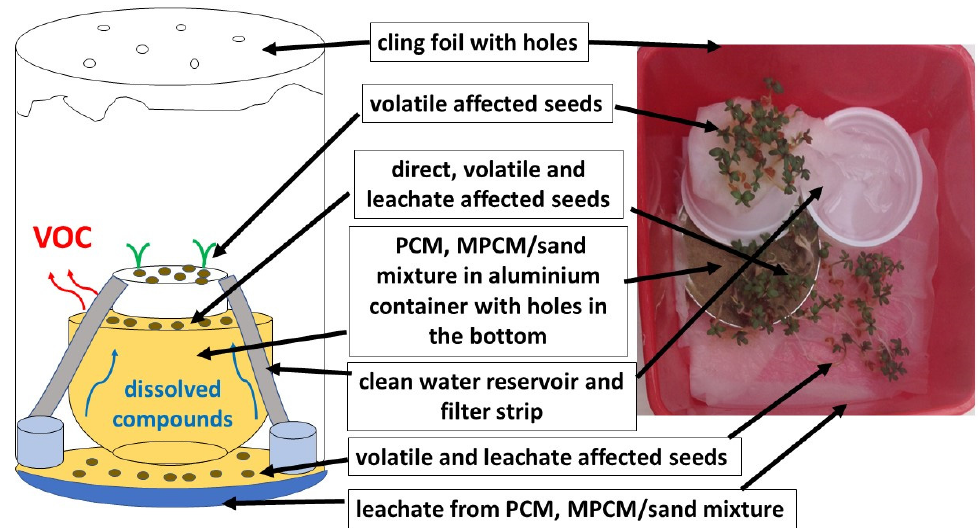
Figure 1. Experimental design for the germination test for assessing the effect of direct contact, released volatile and dissolved compounds in water.